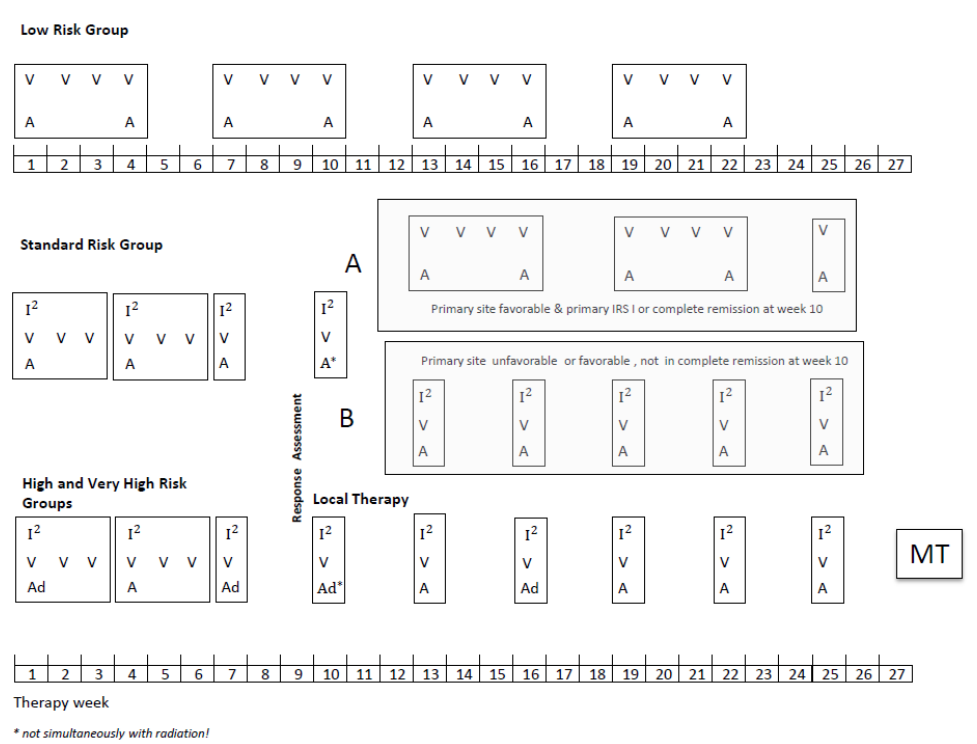
Figure 1. CWS-2002P treatment plan.